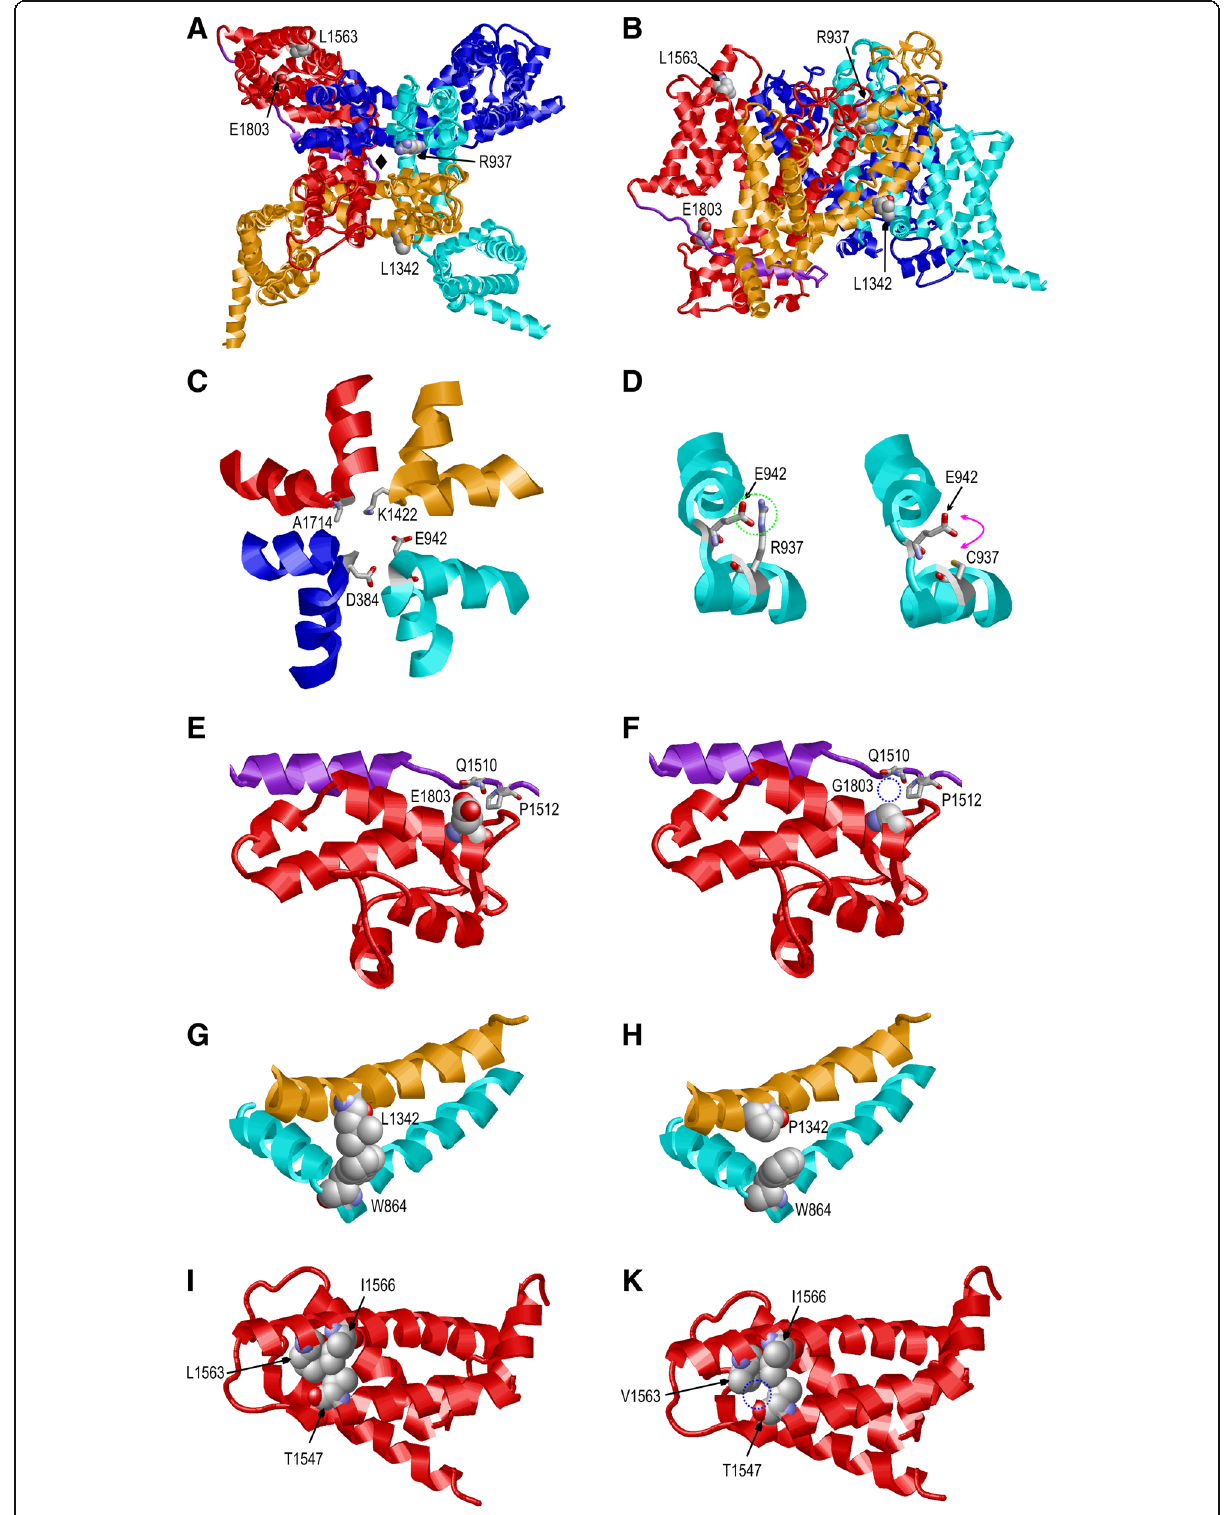
Fig. 3 (See legend on next